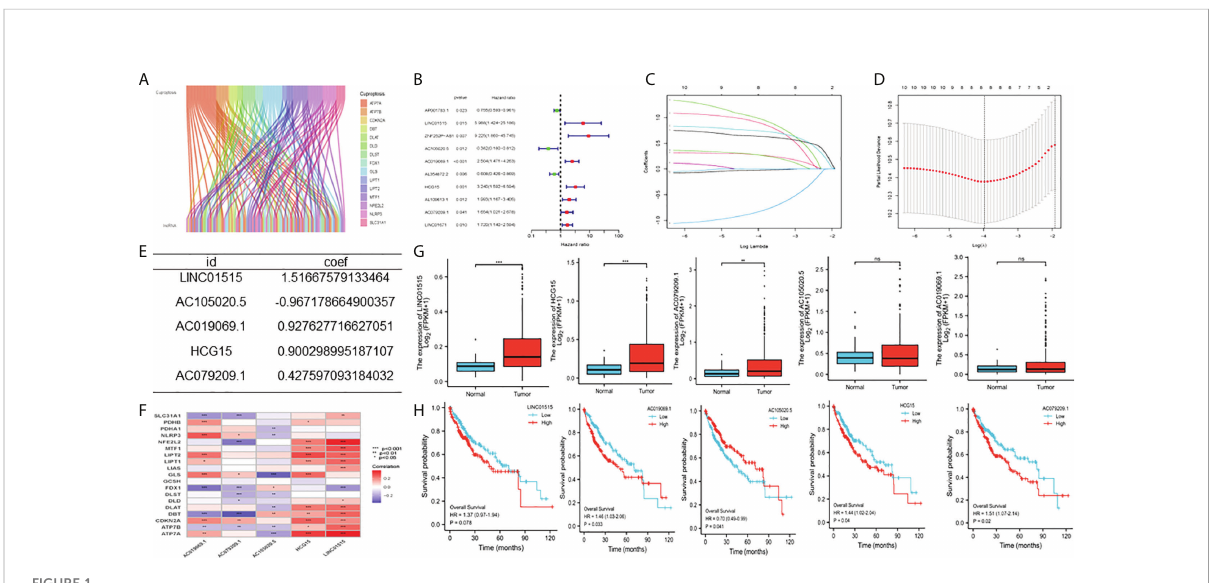
FIGURE 1 Construction of cuproptosis-related characteristics m TCGA-LIHC cohort (A) Co-expression analysis of cuproptosis related locRNAs,